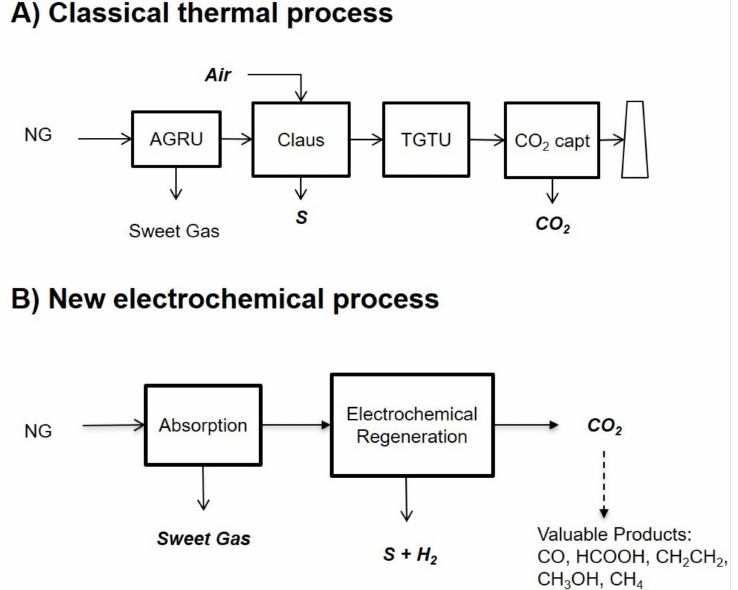
Figure 1. ( A ) A classical thermal process to capture CO 2 from natural gas (NG) when H 2 S is also present. First, both gases are removed in an AGRU (containing both absorption and thermal regeneration). In a Claus unit, the H 2 S is converted into solid sulfur, and the remaining sulfur compounds are removed in a TGTU unit. A second AGRU removes the CO 2 before incineration of the remaining gases. ( B ) The electrochemical-based process proposed in this work involves capturing CO 2 from gas in the presence of H 2 S. Both gases are first absorbed with an aqueous amine solvent. The regeneration is electrochemical, not thermal, with simultaneous conversion of H 2 S in solid S and H 2 and separation of CO 2